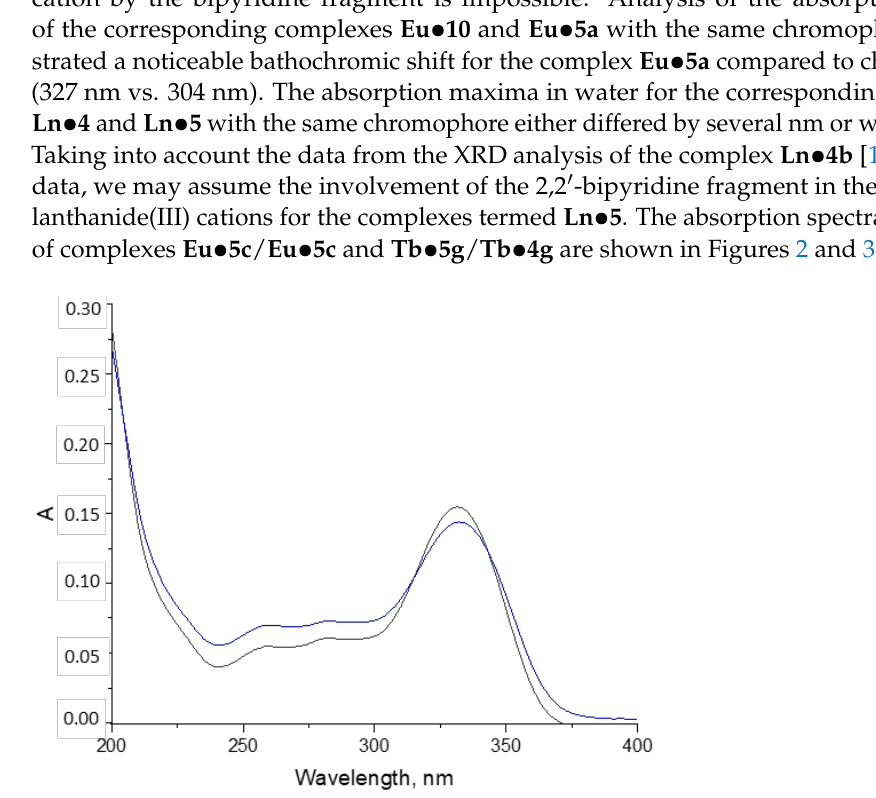
Figure 2. Absorption spectra of complexes Eu • 5c (black line) and Eu • 4c (blue line) in water at room